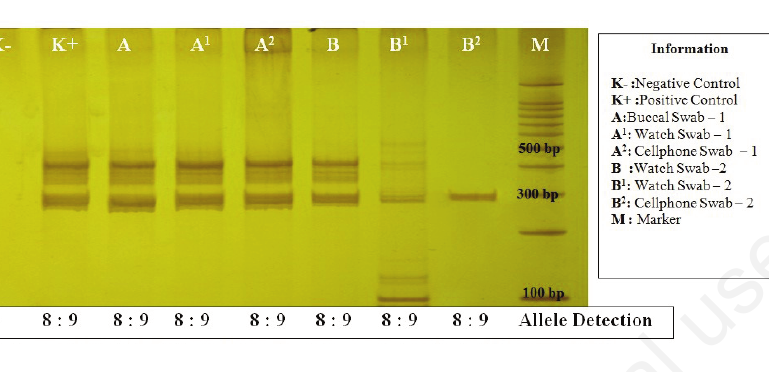
Figure 3. Visualization of STR CODIS PCR product using at locus TPOX (262–90